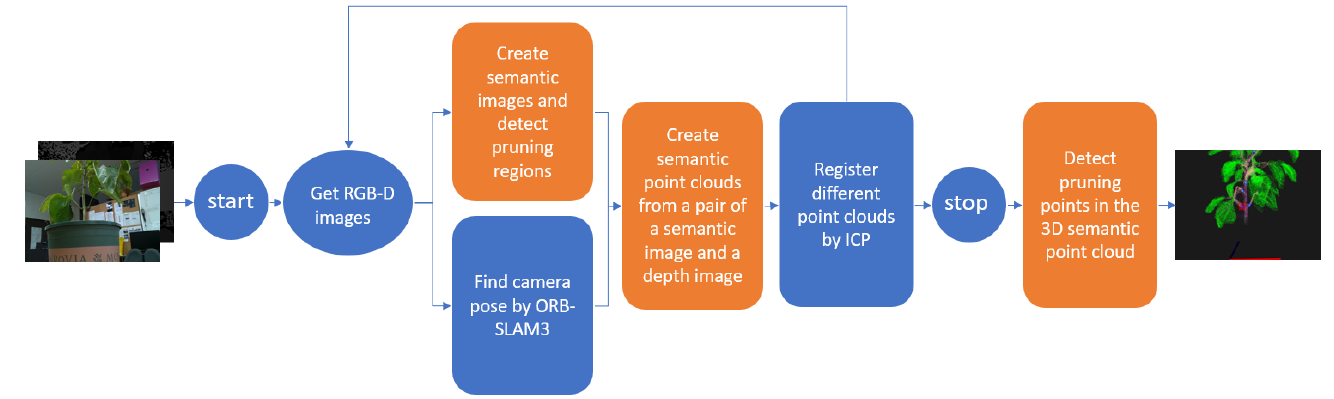
Figure 9. Structure of the sweet pepper leaf pruning point detection system. The orange rectangles are our proposed modules. The red point in the final semantic point cloud is the pruning point of the lowest petiole. lowest